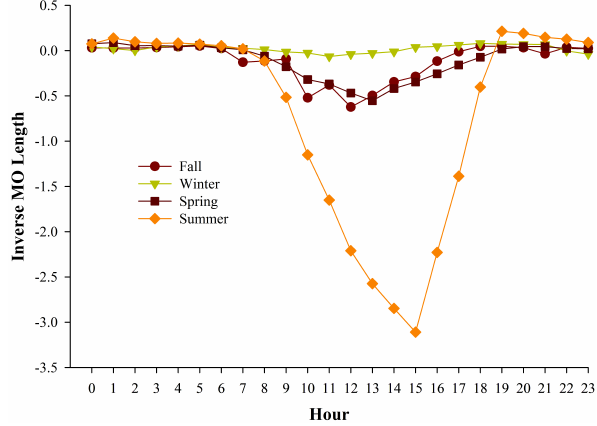
Obukhov (MO) length (1/ L ) (m − 1 ) measured from 1 November 2006 to 29 June 2007 measured at Elora Research Station, ON. 1/ L > 0 indicates stable atmospheric conditions, 1/ L = 0 indicates neutral atmospheric conditions and 1/ L < 0, indicates unstable at- mospheric conditions.